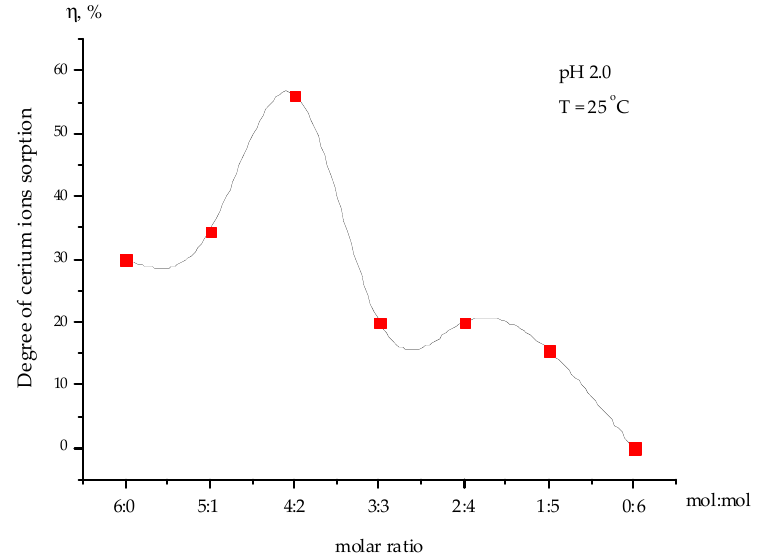
Figure 4. The sorption degree of cerium ions from the uranium-containing solution by the interpolymer system “Amberlite IR120H:AV-17-8” (X:Y) (6:0, 5:1, 4:2, 3:3, 2:4, 1:5, and 0:6) at pH 2.0 after 48 h of interaction.